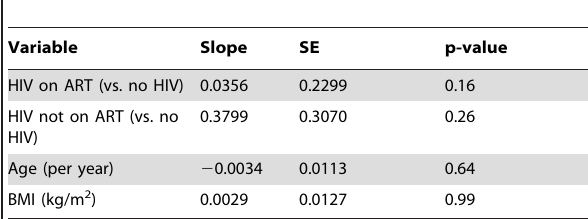
Table 4. Multiple Linear Regression Model for BAL